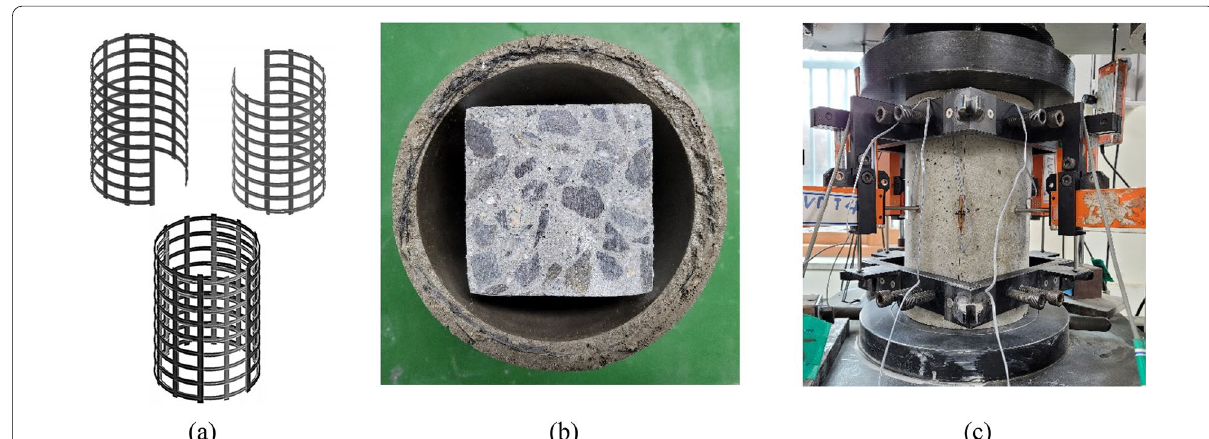
Fig. 6 Confinement test: a prism confined by FRCM tube with lap-spliced fabrics. a Fabrication of lap-spliced fabrics; b prism and C-FRCM tube before casting filler mortar; c test under progress.